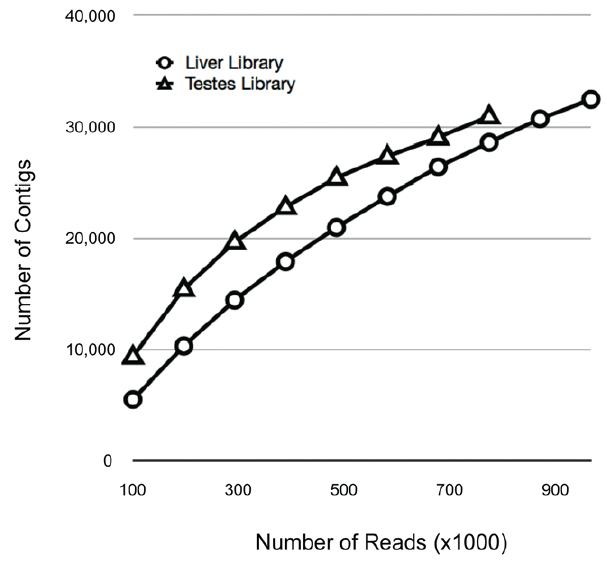
Figure 4. Rarefaction analysis of quality trimmed reads from each library. Rarefaction analysis was used to determine level of contig discovery relative to sequencing effort. Reads were sequentially sampled in 1 6 10 5 sequence read increments and de novo assembled.